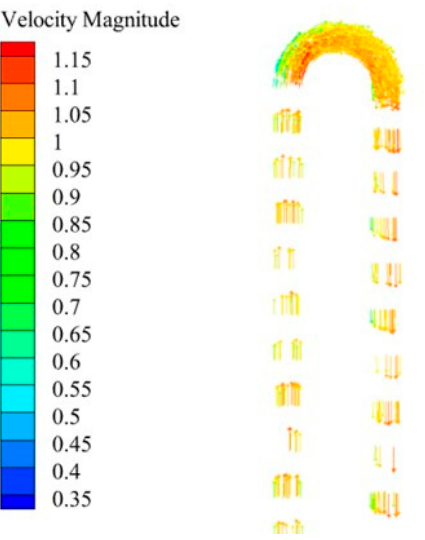
Figure 8. Velocity field in the U ‐ shaped tube.